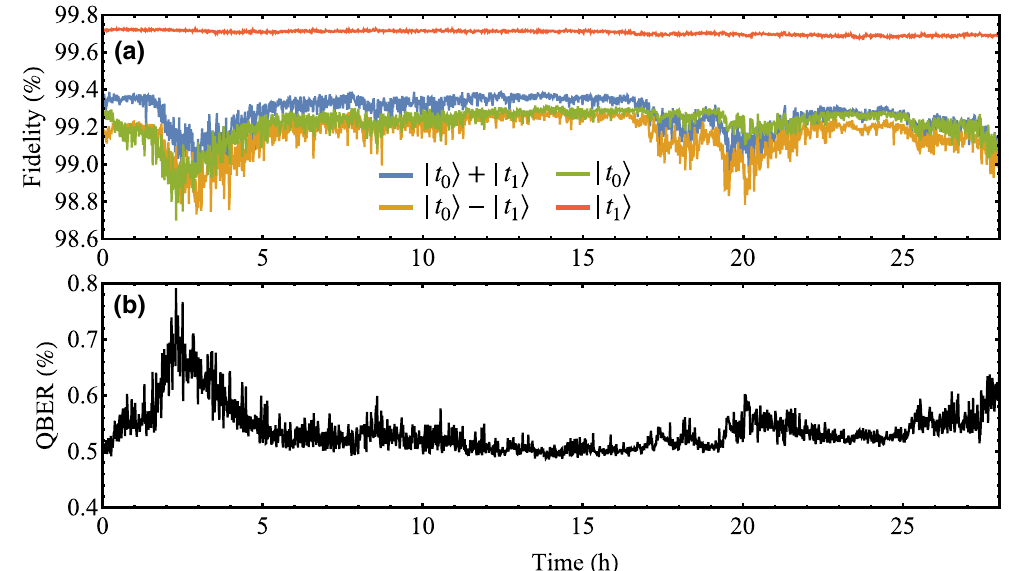
FIG. 5. Time-bin measurement over 28 h. (a). The state fidelity for all four measured states, i.e., | φ 0 (cid:2) (blue curve), | φ 1 (cid:2) (yellow curve), | t 0 (cid:2) (green curve), and | t 1 (cid:2) (red curve). (b) The QBER is calculated from the state fidelity averaged over all